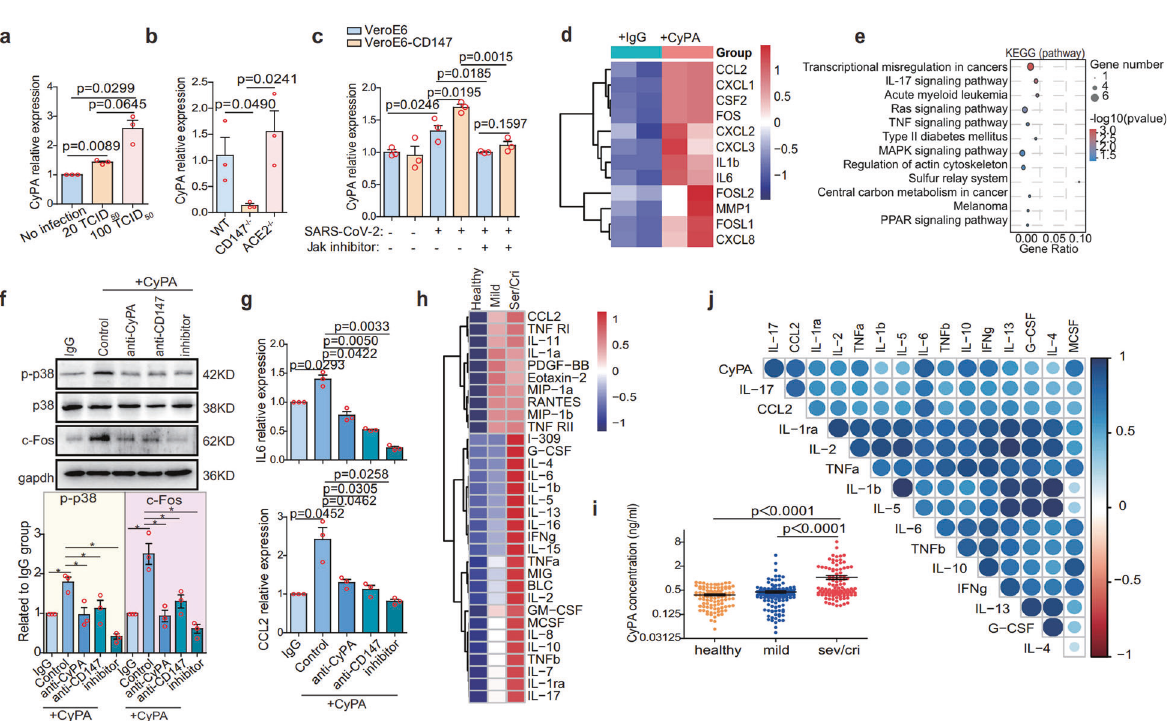
Fig. 5 Spike protein-CD147-CyPA axis contributes to COVID-19 cytokine storm. a SARS-CoV-2-infected VeroE6 cells with different titers were incubated for 48 h, and RNA was collected for CyPA detection by RT-qPCR ( n = 3, Two-tailed student t test). b CD147 or ACE2 in VeroE6 cells was knocked out by CRISPR-Cas9, and the cells were then infected with SARS-CoV-2 for 48 h. The expression level of CyPA was detected by RT- qPCR ( n = 3, Two-tailed student t test). c CD147 in VeroE6 cells was ectopically expressed by lentivirus, the cells were then infected with SARS- CoV-2 for 48 h with or without JAK inhibitor. The expression level of CyPA was detected by RT-qPCR ( n = 3, Two-tailed student t test). d Heatmap of signi fi cantly upregulated genes based on RNA-seq. BEAS-2B cells were stimulated with or without CyPA for 48 h. Columns represent samples and rows represent genes. Gene expression levels in the heat maps are z score – normalized values determined by log 2[CPM] values. e KEGG enrichment analysis of pathways enriched in upregulated genes from the CyPA-stimulated group compared with the control group. f Western blot analysis of p-p38, p-38, and c-FOS expression ( n = 3, Two-tailed student t test, * p < 0.05). g IL-6 and CCL2 expression detected by RT-qPCR. h The heatmap of 32 differential cytokines. Fourty human cytokines were detected in plasma from healthy individuals ( n = 100) and COVID-19 patients ( n = 200, including 41 severe/critical and 159 mild) using cytokine chips. i CyPA prote i n detected in the plasma of healthy donors ( n = 100), COVID-19 patients with mild symptoms ( n = 159) and COVID-19 patients with severe/critical symptoms ( n = 106) by ELISA (Two-tailed student t test). j Correlation analysis between CyPA and cytokines according to the Pearson correlation coef fi cient. Data were collected from the 41 severe/critical